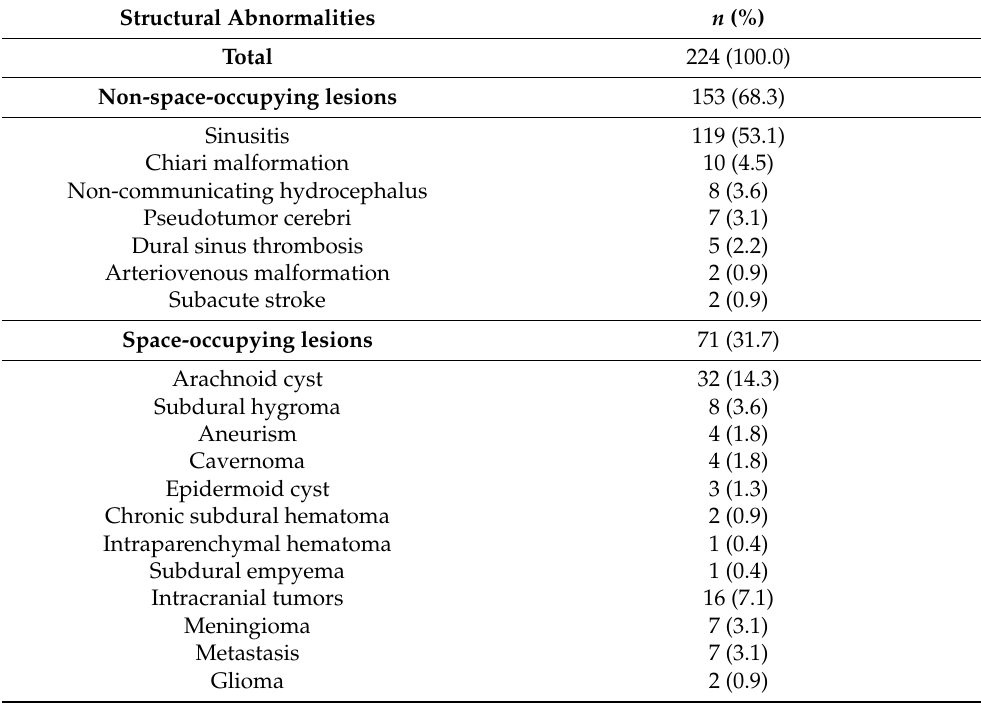
Table 5. Frequency of specific structural abnormalities in the